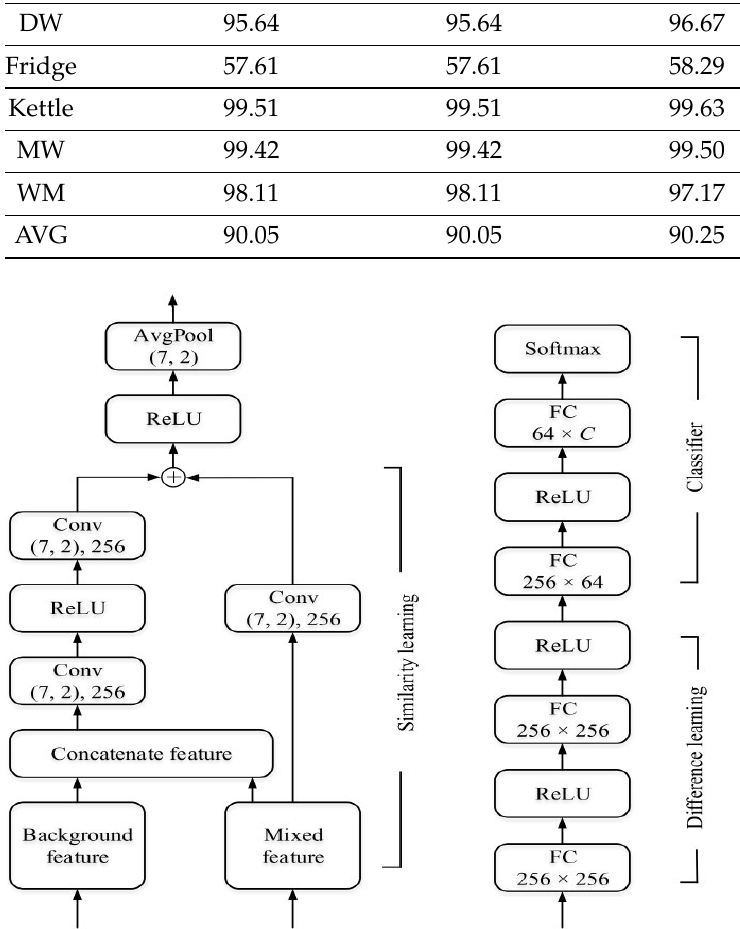
Figure 10. The network architecture of Concatenate-DenseNet121 [11]. Reprinted from ref.